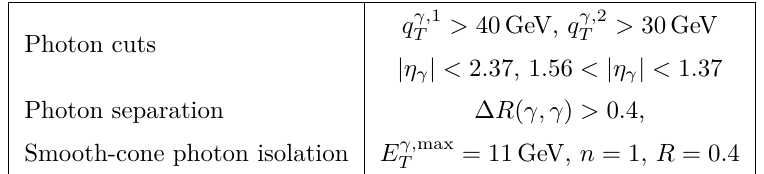
√ s = 8 TeV , see ref.